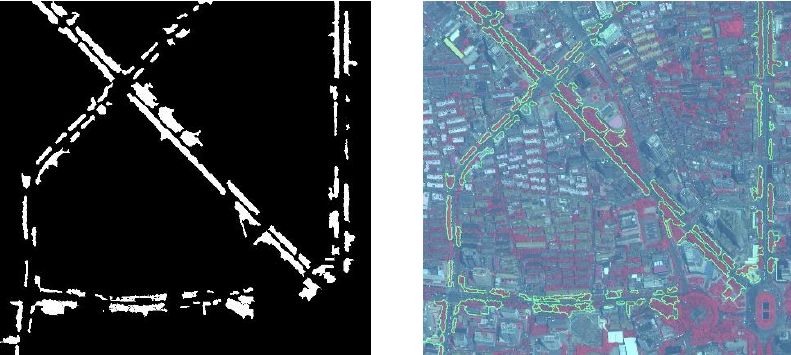
Figure 4. The watershed segmentation results by the